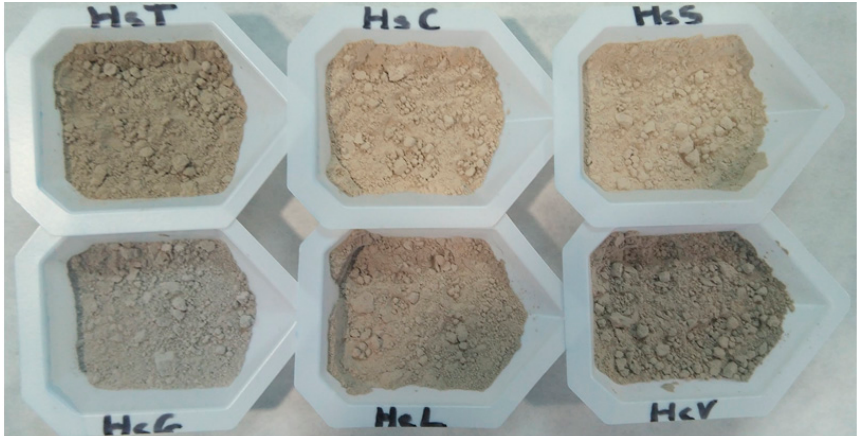
Figure 1. Samples after grinding and sieving to <63 μ m.